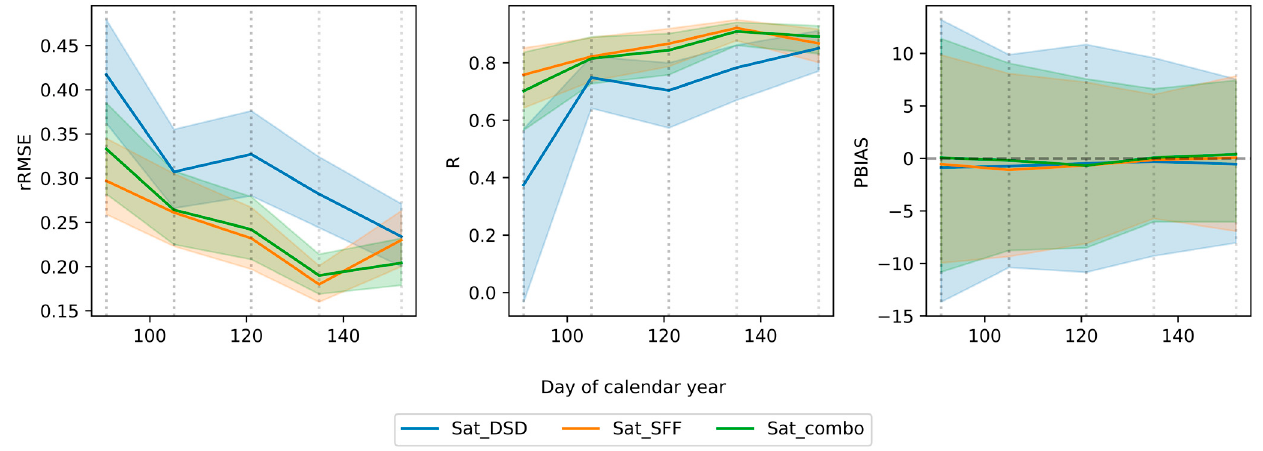
Figure 3. The median relative RMSE, correlation, R, and percent bias, PBIAS, error statistics for three different satellite-based water supply forecasts in the East R. basin, with interquartile range (25/75 percentiles) shaded. Vertical dotted lines denote the days chosen for forecasting—1 April, 15 April, 1 May, 15 May, and 1